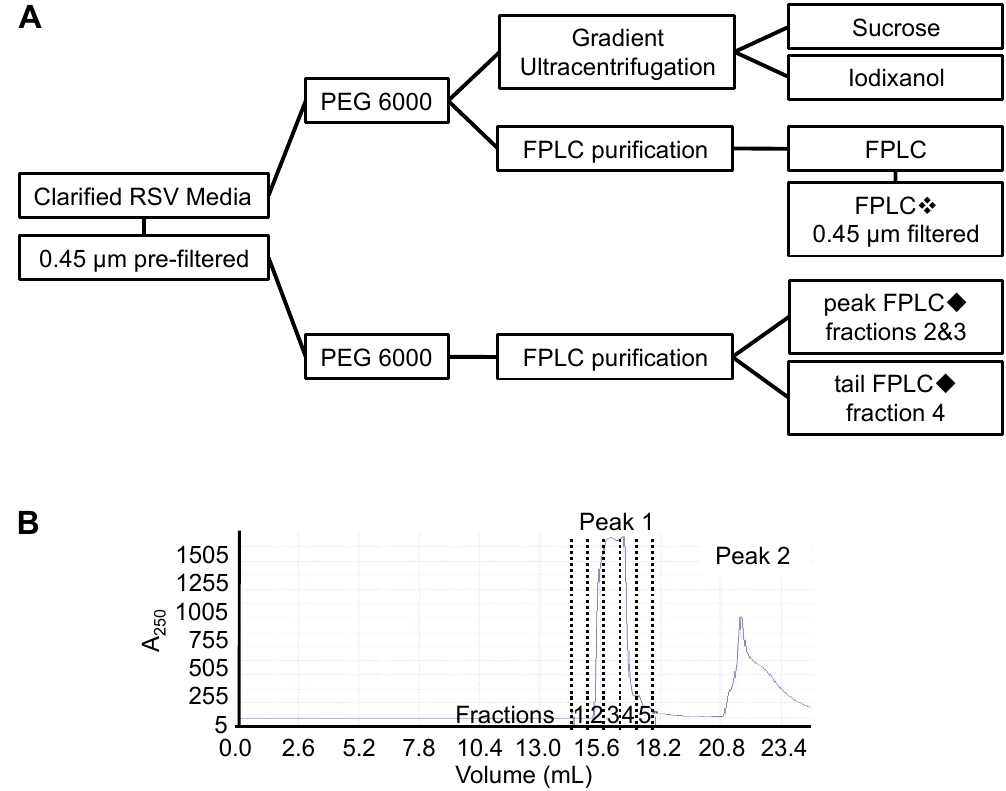
Figure 1. Respiratory Syncytial Virus (RSV) purification workflow. ( A ) Schematic of RSV purification methods. Pre- or post-fast protein liquid chromatography (FPLC) 0.45 μ m syringe filtration steps are